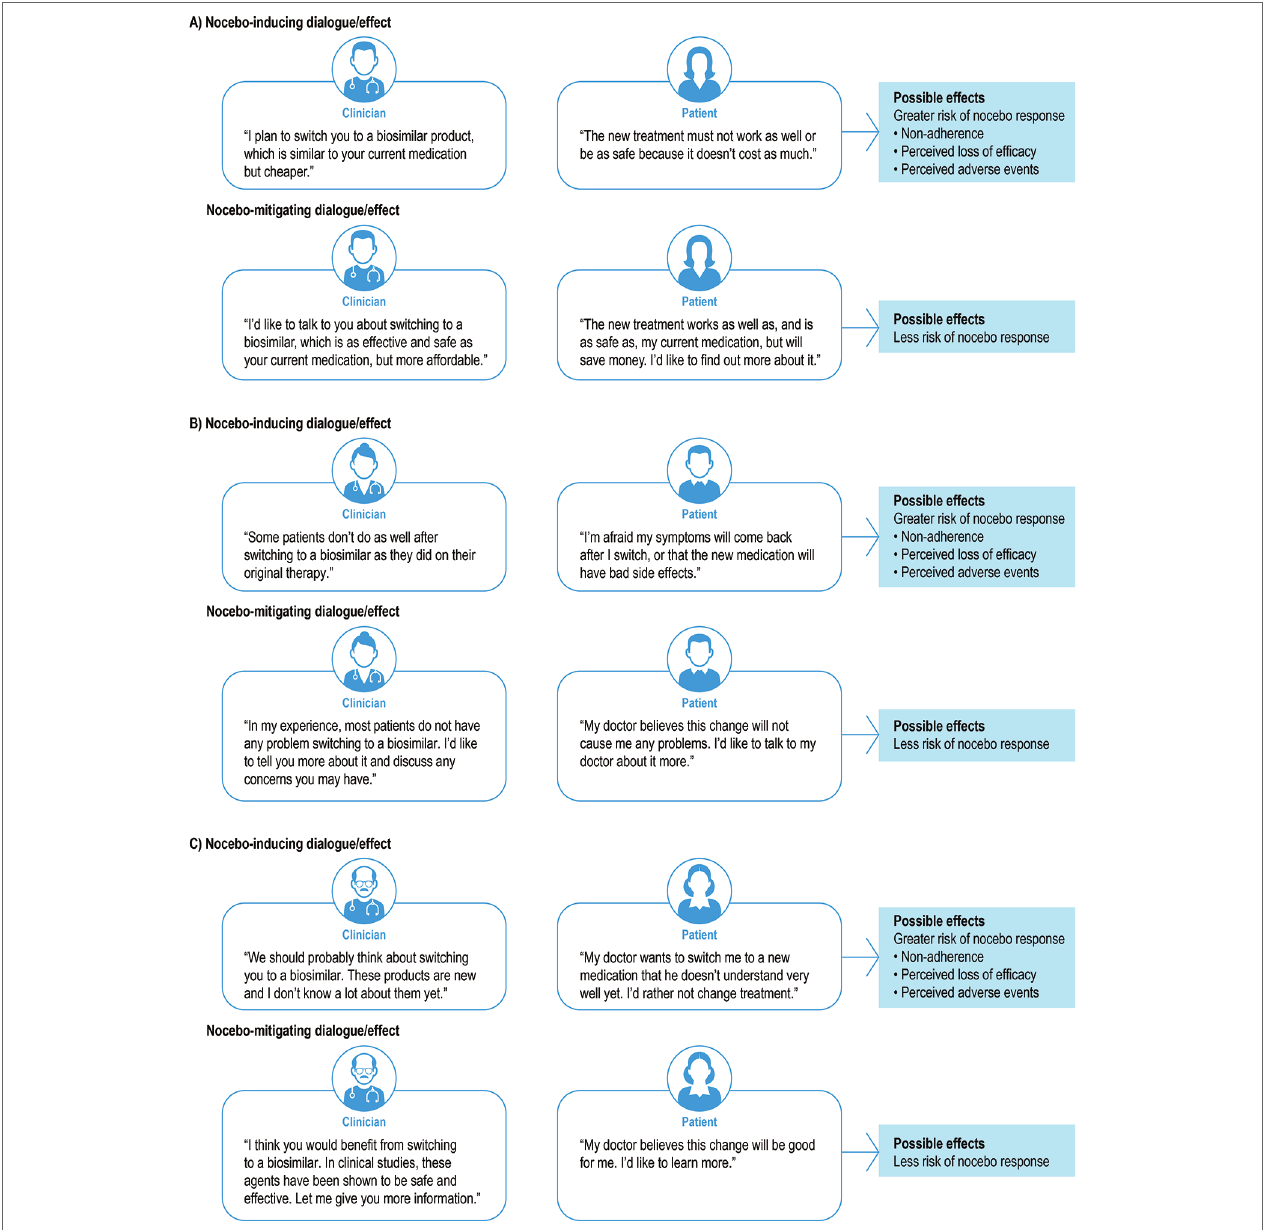
FIGURE 1 | Examples of patient–clinician interaction that may trigger/avoid nocebo effects in patients switching from an originator biologic to a biosimilar.